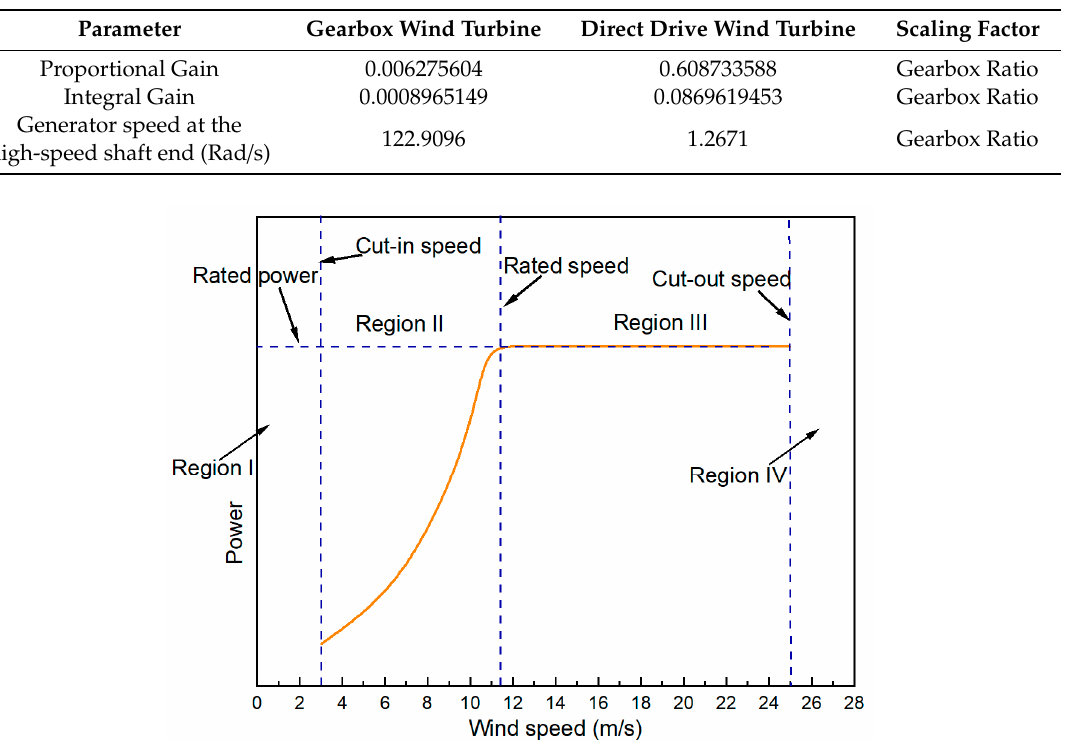
Table 1. Blade pitch control parameter modifications [39,41].